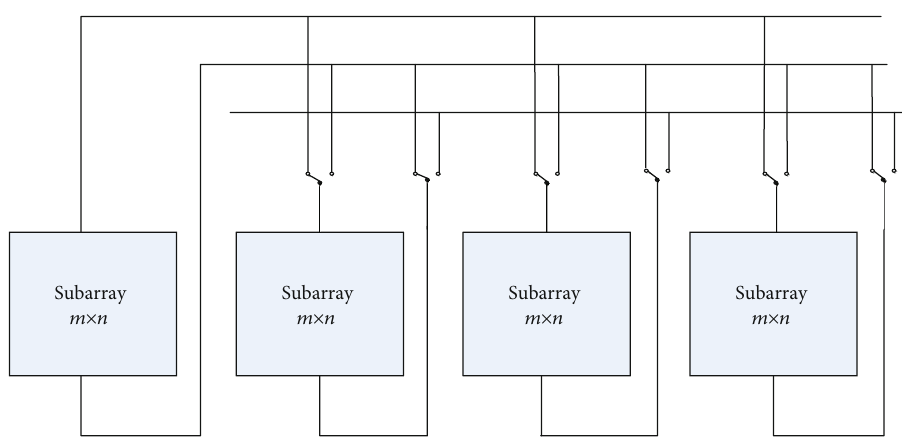
Figure 5: Internal circuit of the switching matrix for a 2 × 2 photovoltaic